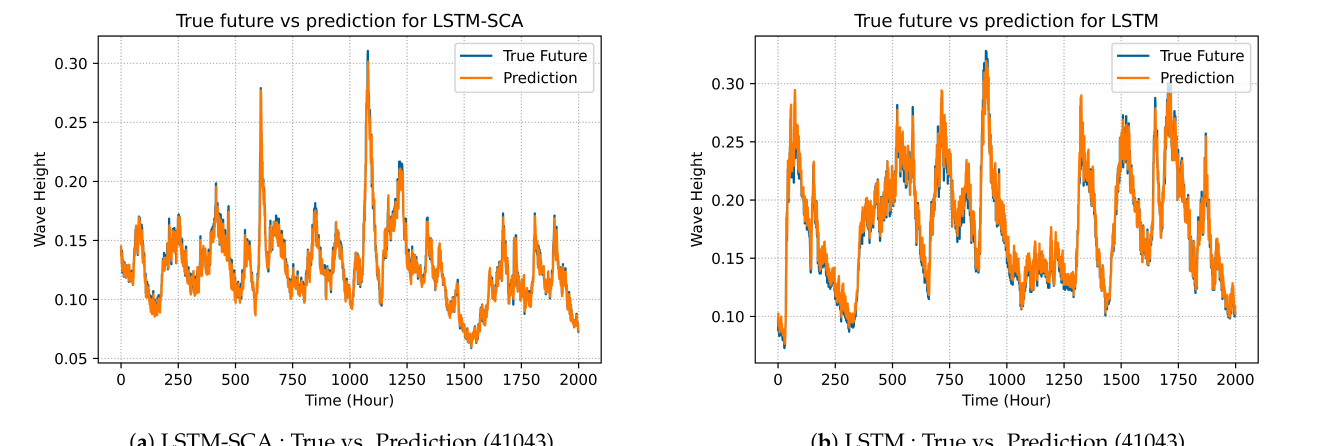
Figure 9. Comparison of VRNN models on dataset 41043.